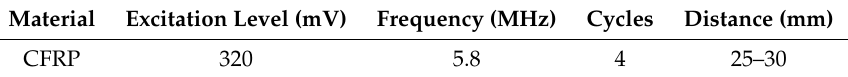
Table 2. Selected parameters to measure the nonlinear parameter in